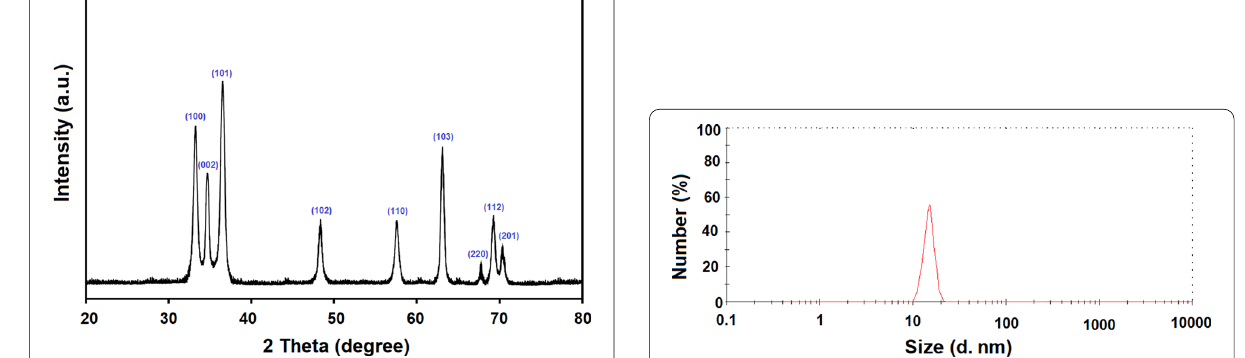
Fig. 3 Particle size distribution of ZnONPs synthesized by the fungus A.